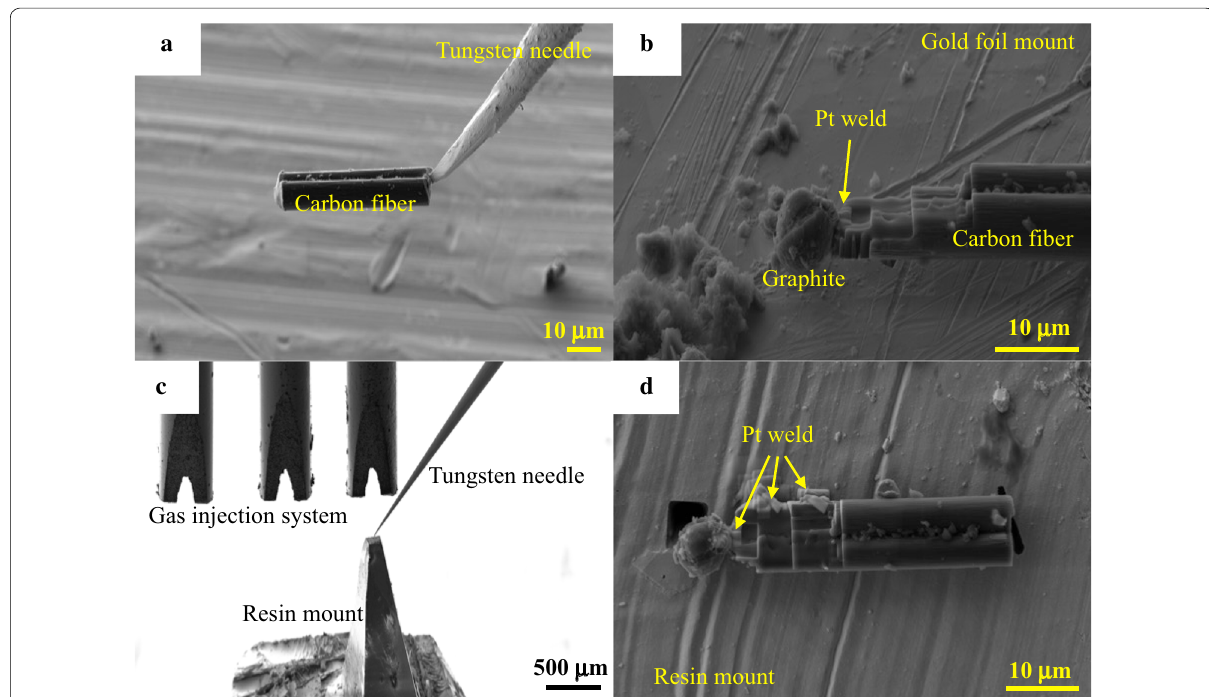
Fig. 2 The procedure of sample transferring with FIB. a A carbon fiber was welded on the tip of a tungsten needle. b A graphitic spherule was welded with a shaped carbon fiber. c Transferring onto a resin base. d Fixing on the top and cutting off the carbon fiber